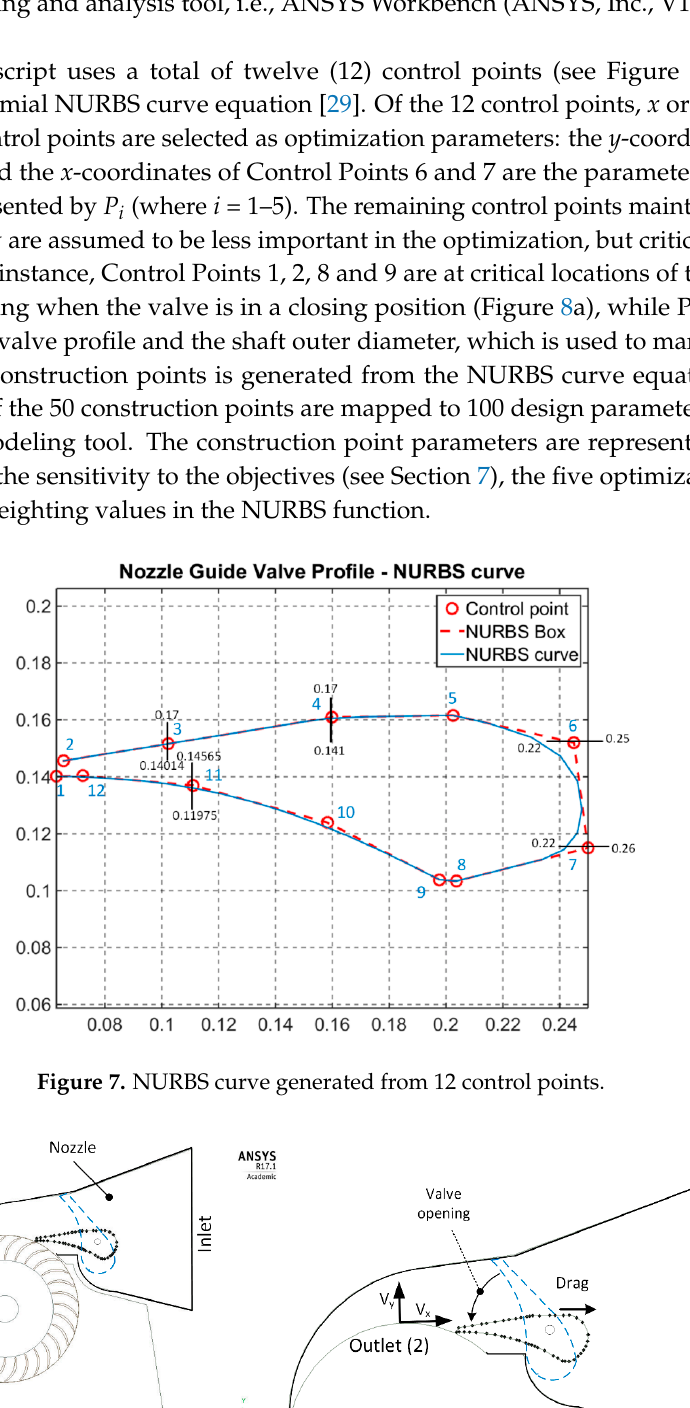
Figure 6. Optimization approach flowchart: inter-connection of OASIS, MATLAB and ANSYS Workbench tools.